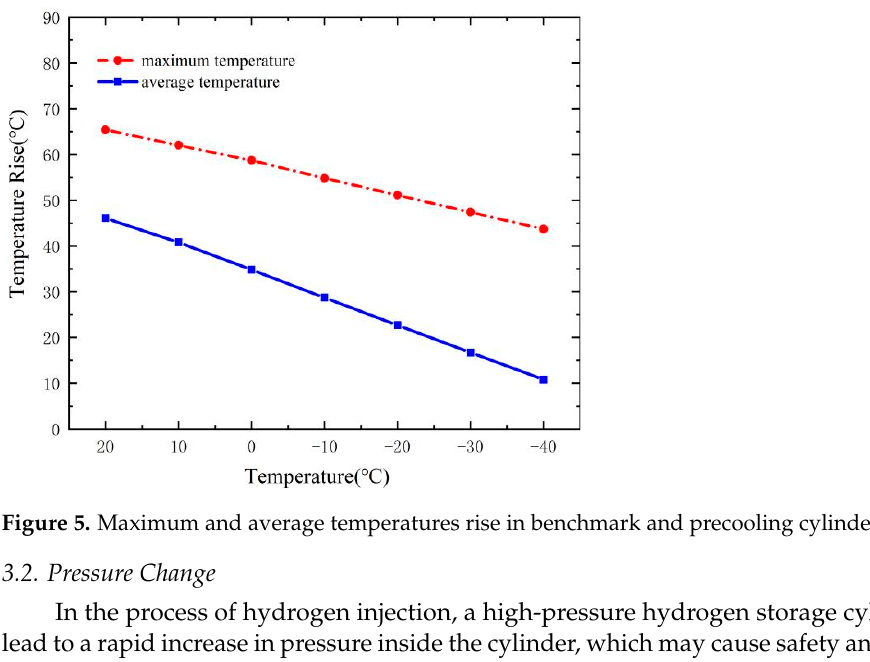
Figure 5. Maximum and average temperatures rise in benchmark and precooling cylinders (t = 90 s).